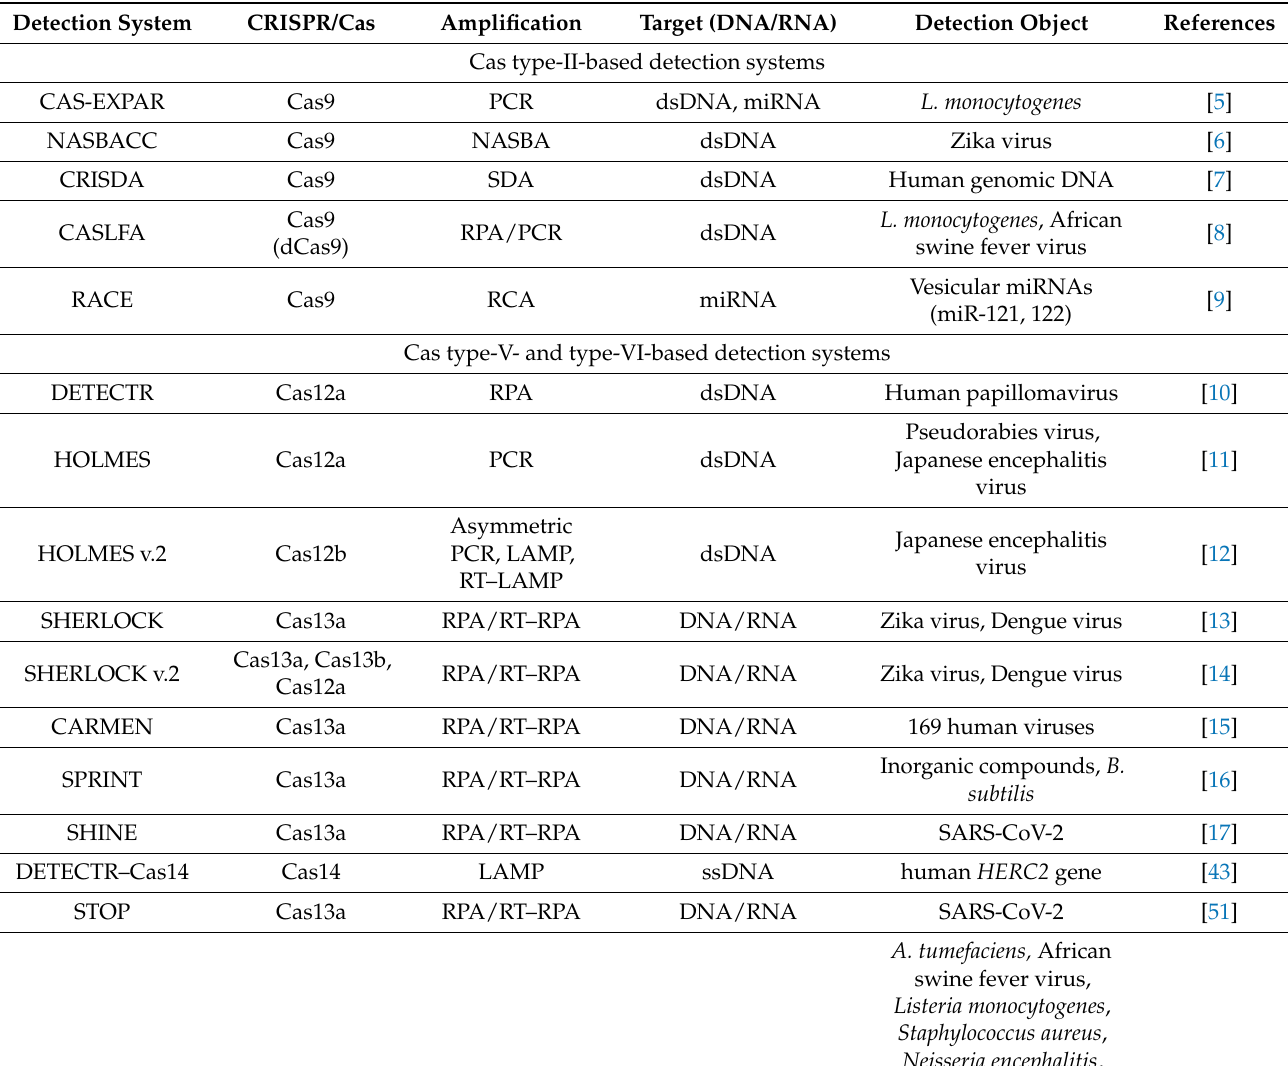
Table 1. Nucleic acid detection systems based on the activity of Cas